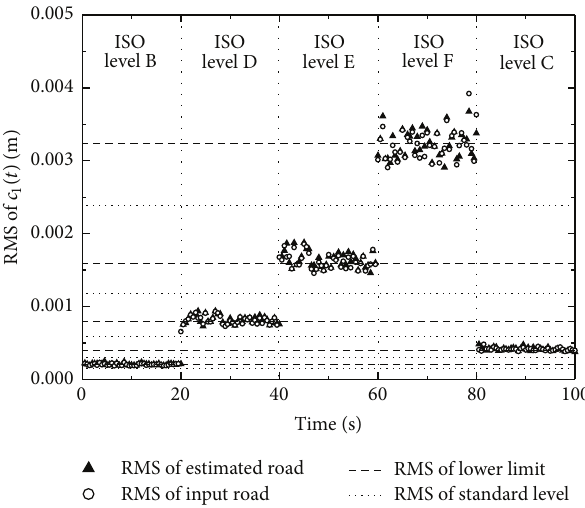
Figure 8: Classification of road profile with detail